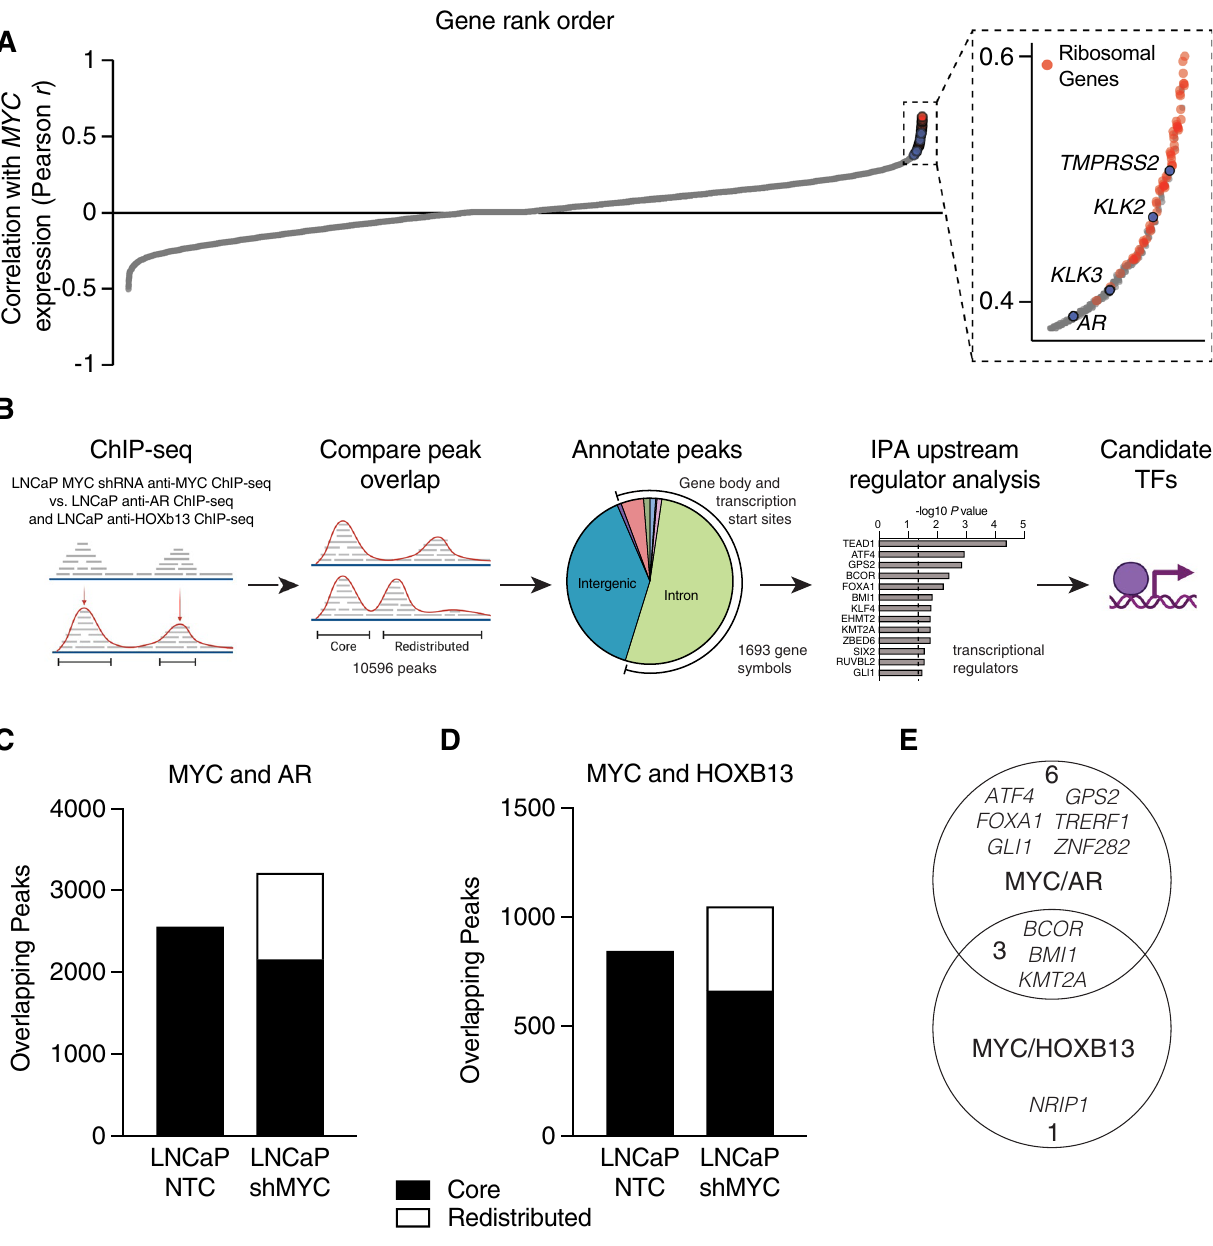
Fig. 1 Identification of transcription factors associated with MYC redistribution at AR- and HOXB13-occupied sites. A Ranked order depic- tion of genes whose expression correlate with MYC in an institutional cohort of 177 laser-capture microdissected prostate cancer tumor foci. B Schematic of the strategy used to identify upstream transcription regulators based on co-occupied peaks in LNCaP ChIP-seq data. anti- MYC [22], anti-AR, and anti-HOXB13 ChIP-seq data [23] used for analyses. C , D Bar plots showing the total peak number of MYC co-occupied sites, characterized as “core” or “redistributed” peaks, for anti-AR ( C ) and anti-HOXB13 ( D ) ChIP-seq. E Venn diagraph showing the overlap between transcription regulators identified by MYC/AR and MYC/HOXB13 co-occupied genes and nominated Ingenuity Upstream Regulator